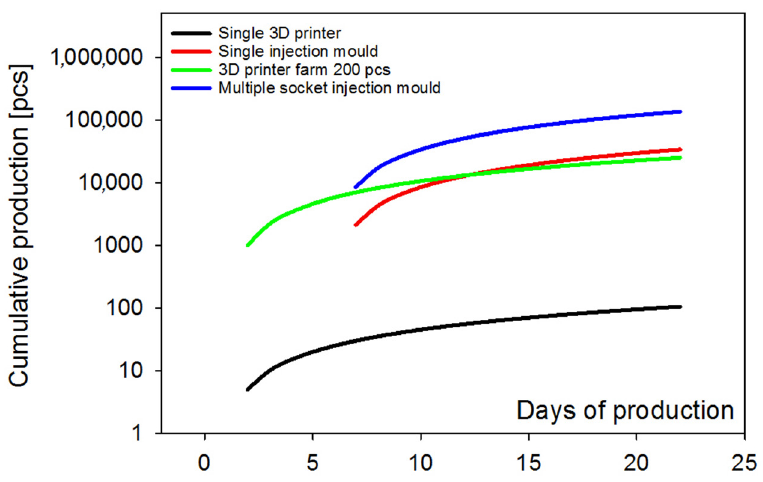
Figure 3. Comparison of the cumulative production volume of an item as a function of time for various manufacturing techniques.